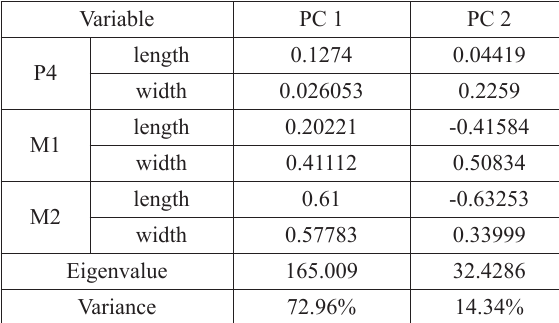
Table 3. Principal component loadings of teeth variables in analyzed sample of brontotheres. PC, Principal Component.